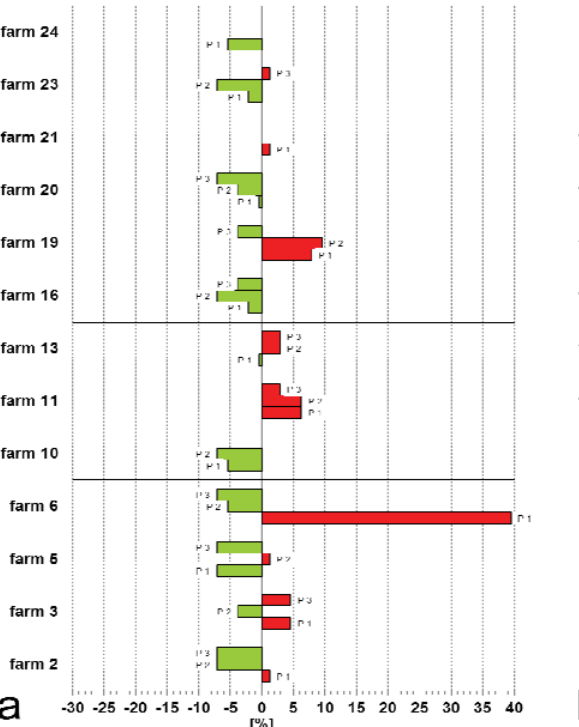
Figure 3. Farm specific deviations concerning prevalence of breast buttons ( a ) Hens (arithmetic mean: 7.8%). ( b ) Toms (arithmetic mean: 27.2%). Green bars: better than average; red bars: worse than average. P: observed rearing